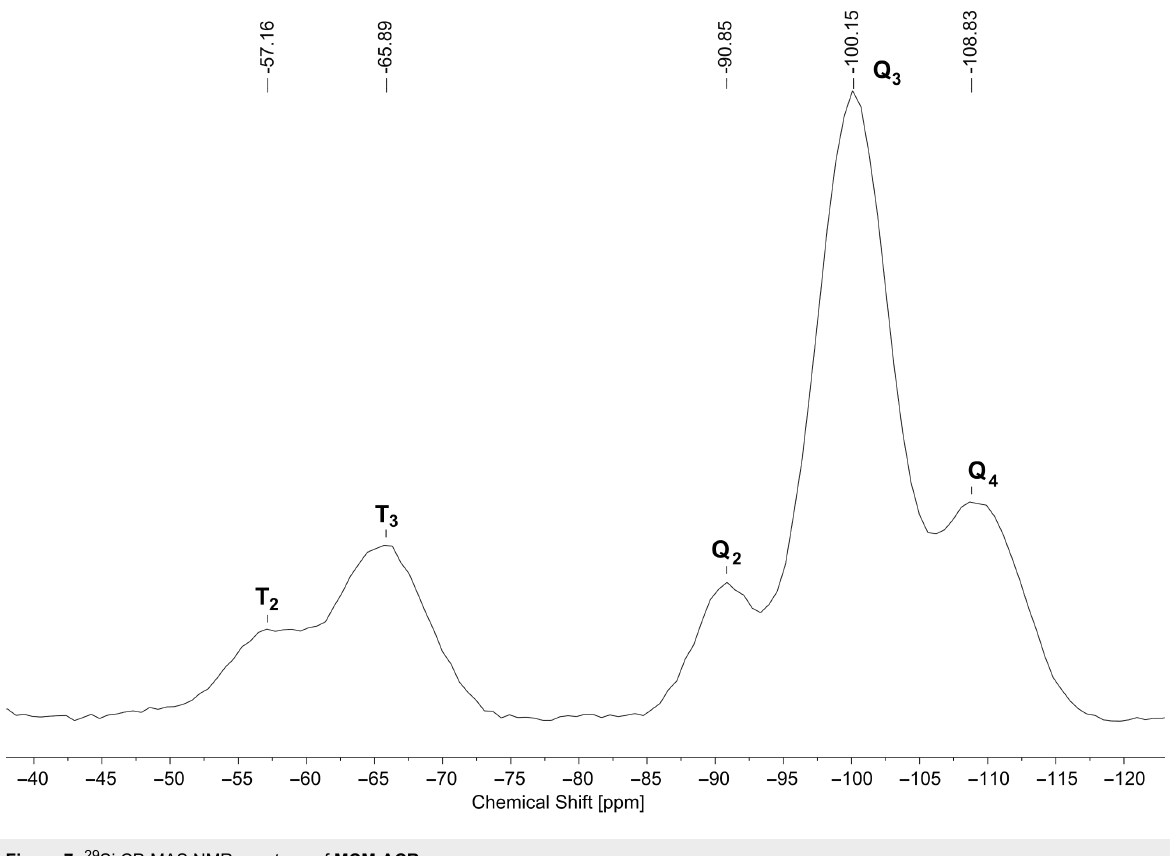
phenomenon might be the energy splitting caused by the coupled CO stretching within the acridone–Sc 3+ complex